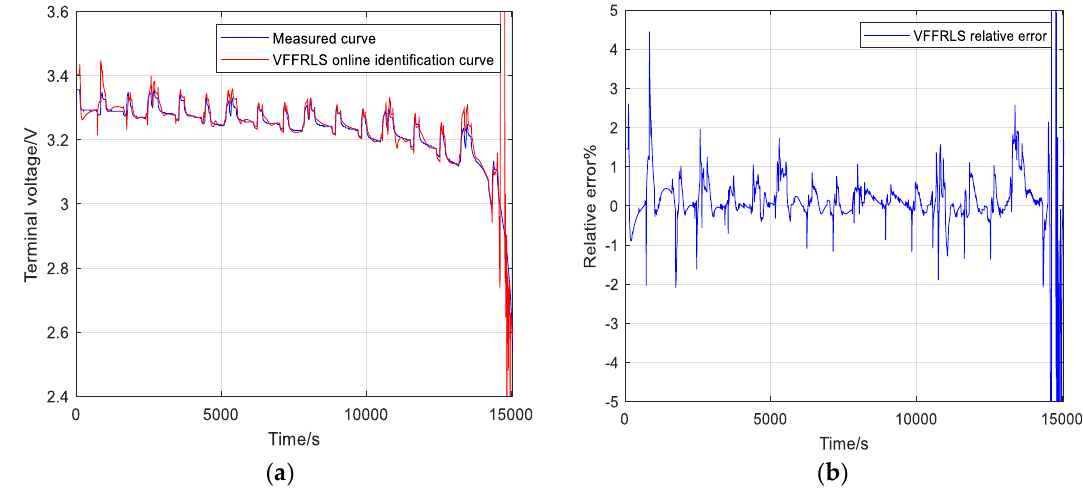
Figure 12. Comparison of the measured terminal voltage and the terminal voltage identified by the VFFRLS algorithm of the literature [16] with a certain weight coefficient: ( a ) Terminal voltage comparison curve; ( b ) Relative error of terminal voltages.